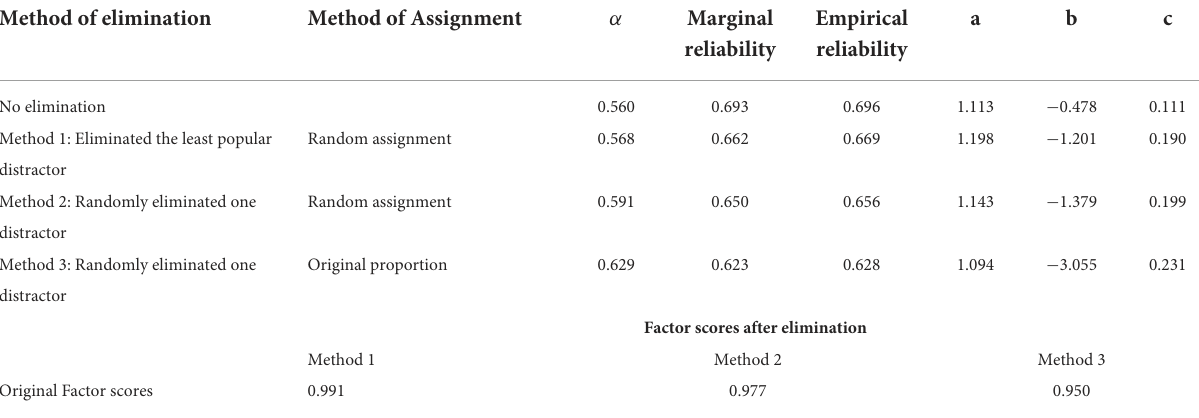
TABLE 3 Test reliability, test scores, and item parameter estimates after eliminating